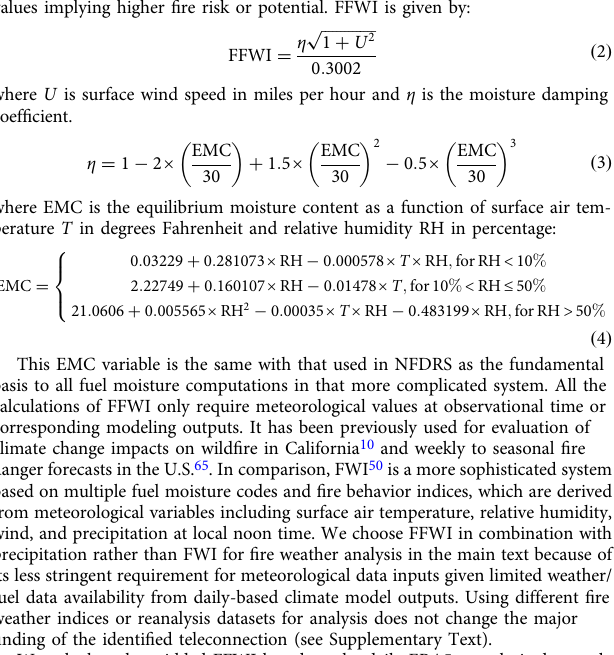
Fig. 2b are also normalized for direct comparison against each other before the composite and correlation analysis. The univariate (1-D) and bivariate (2-D) distribution densities for each index in Fig. 2b-e are then generated and visualized using the Seaborn Python library 67 based on the Kernel Density Estimation (KDE) method, which is a non-parametric way to estimate the probability density function of a random variable. The bi-monthly Multivariate El Niño-Southern Oscillation index (MEI; positive/negative values correspond to El Nin ̃ o/La Niña events, respectively) 68 is the time series of the leading combined Empirical Orthogonal Function (EOF) of fi ve different variables (sea level pressure, SST, zonal and meridional components of the surface wind, and outgoing longwave radiation) over the tropical Paci fi c basin (30 °S to 30 °N; 100 °E to 70°W). We use MEI for comparing and interpretating the identi fi ed S/NP forced responses. The S/NP1 timeseries in both original and detrended data show strong correlations with MEI ( r = 0.96 with p - value < 0.01 in Supplementary Fig. 10; r = 0.93 with p -value < 0.01 in Supplementary Fig. 12), suggesting this pattern as the most prominent climatic signal is closely related to the coupled ocean-atmosphere conditions in the tropical Paci fi c.